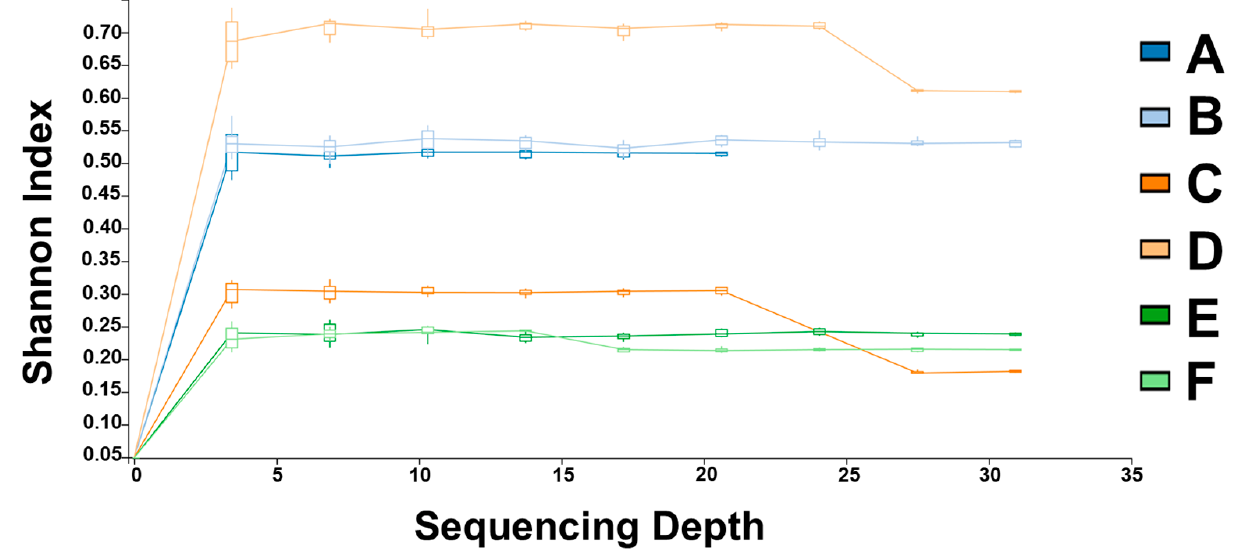
number of Enterococcus , and ( B ) shows the relative abundance of each genus in each of the six corn cultivars. Using metagenome analysis, the different color codes represent various bacterial genera. The figure is based on using six corn varieties [(A) mebaek 2-ho, (B) heukjeom 2-ho, (C) dreamok, (D) oryun popcorn, (E) oryun 2-ho, and (F) meheukchal)]. CFU = Colony forming unit.